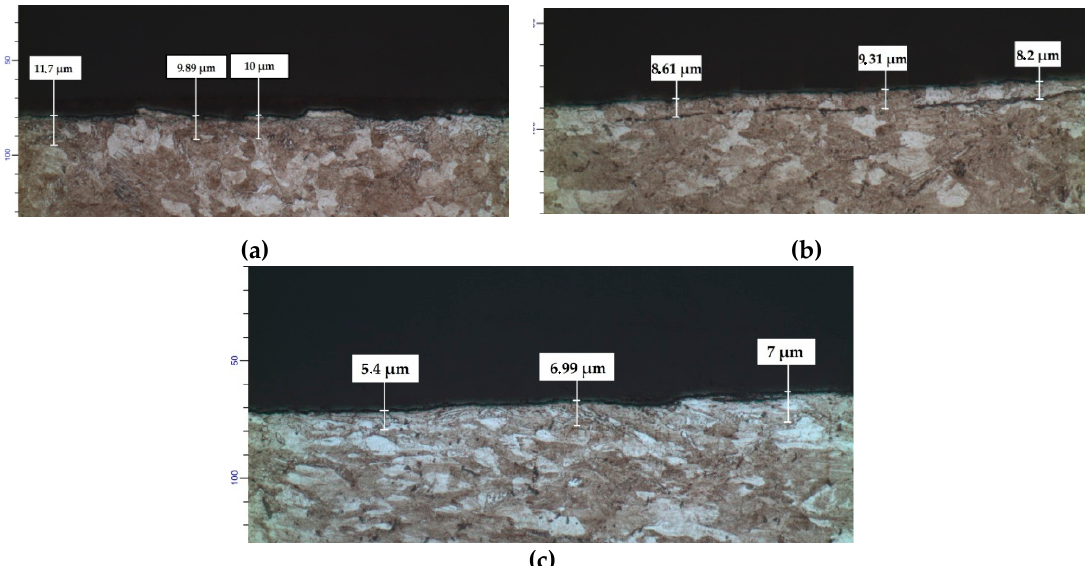
Figure 3. Thickness of fine grain layers after each pass of the multipass drawing process through α = 4° dies: ( a ) the first pass, ( b ) the second pass, ( c ) the third pass.